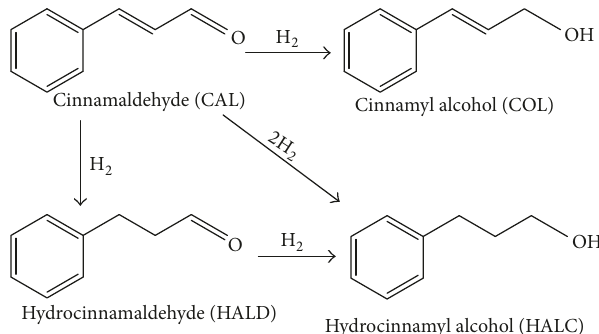
Scheme 1: Hydrogenation products of